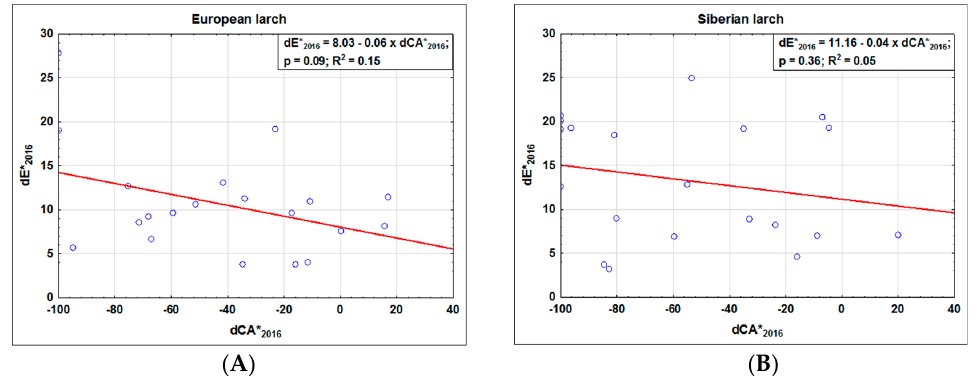
Figure 9. Linear correlations between total colour changes ( Δ E* ) and changes in surface wetting ( Δ CA*) after 2016 h of accelerated weathering of coatings on European ( A ) and Siberian larch wood ( B ). Very poor correlations were also found between Δ E* and gloss changes ( Δ G *): R 2 = 0.02 for European and R 2 = 0.02 for coatings on Siberian larch; between Δ G * and Δ CA*: R 2 = 0.02 for European and R 2 = 0.06 for coatings on Siberian larch wood.